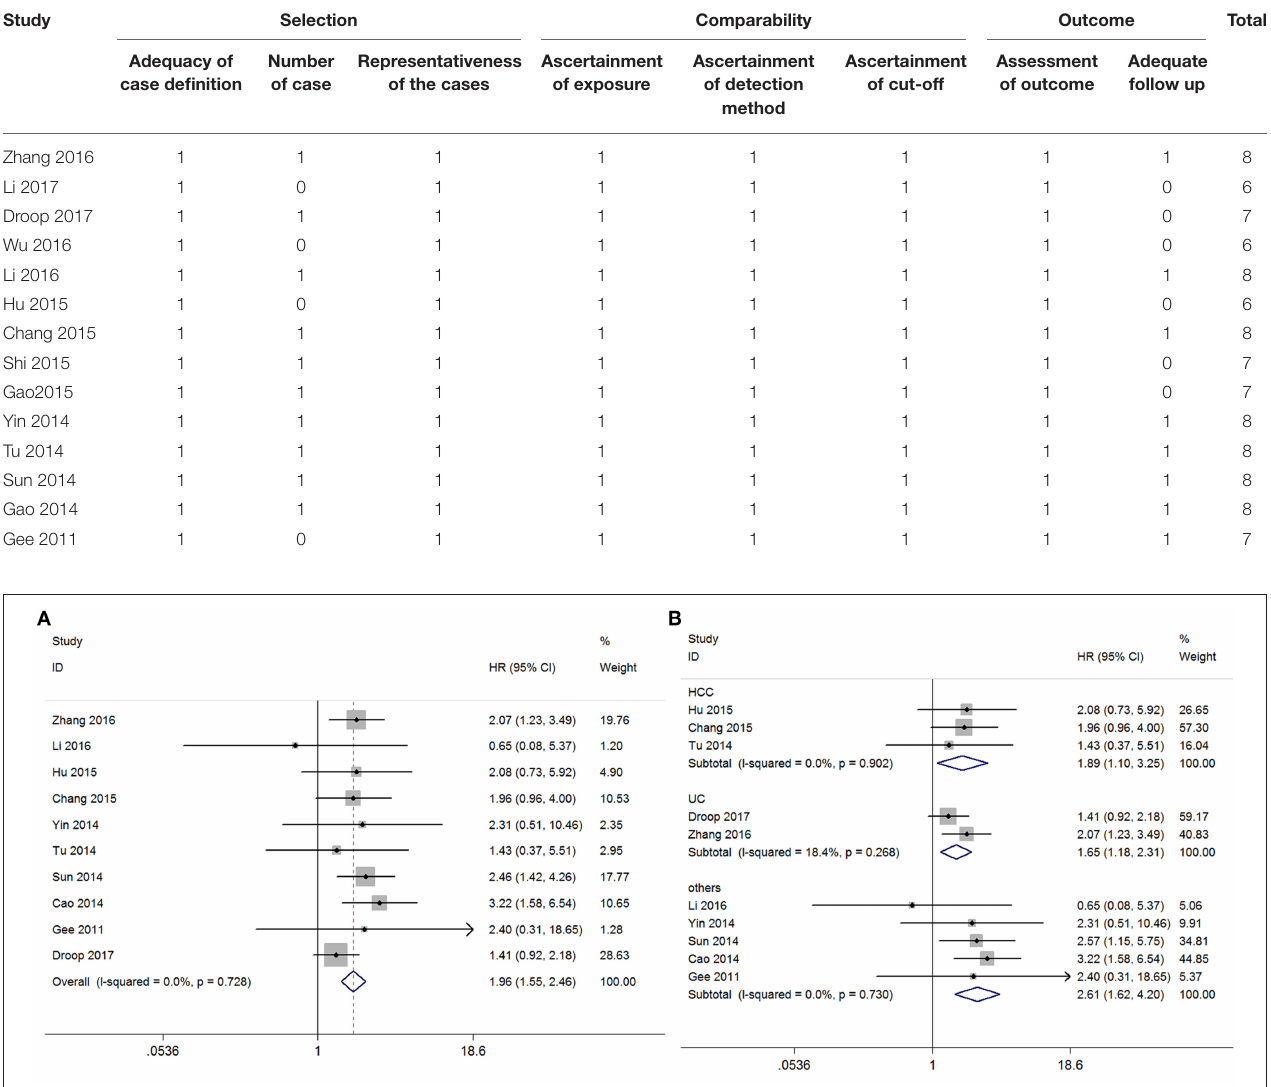
TABLE 2 | Quality assessment of eligible studies (Newcastle-Ottawa Scale).